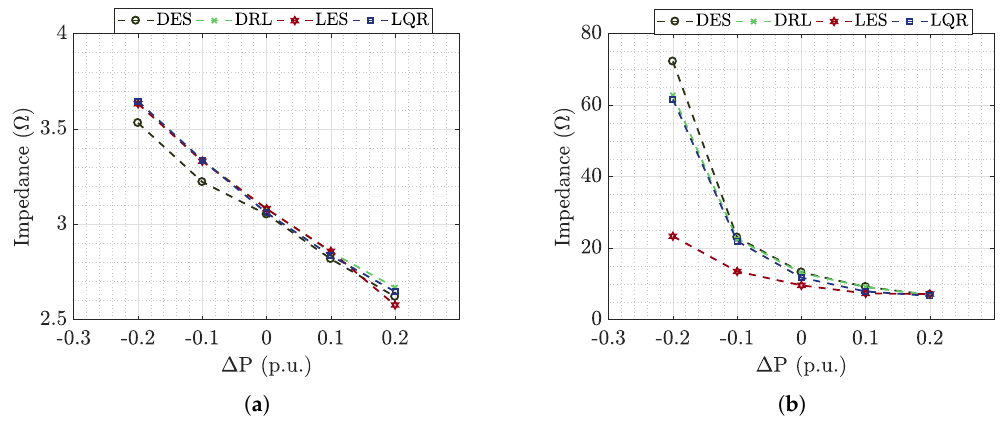
Figure 24. Impedance of the feeder buck in time during the ( a ) simulation and ( b )